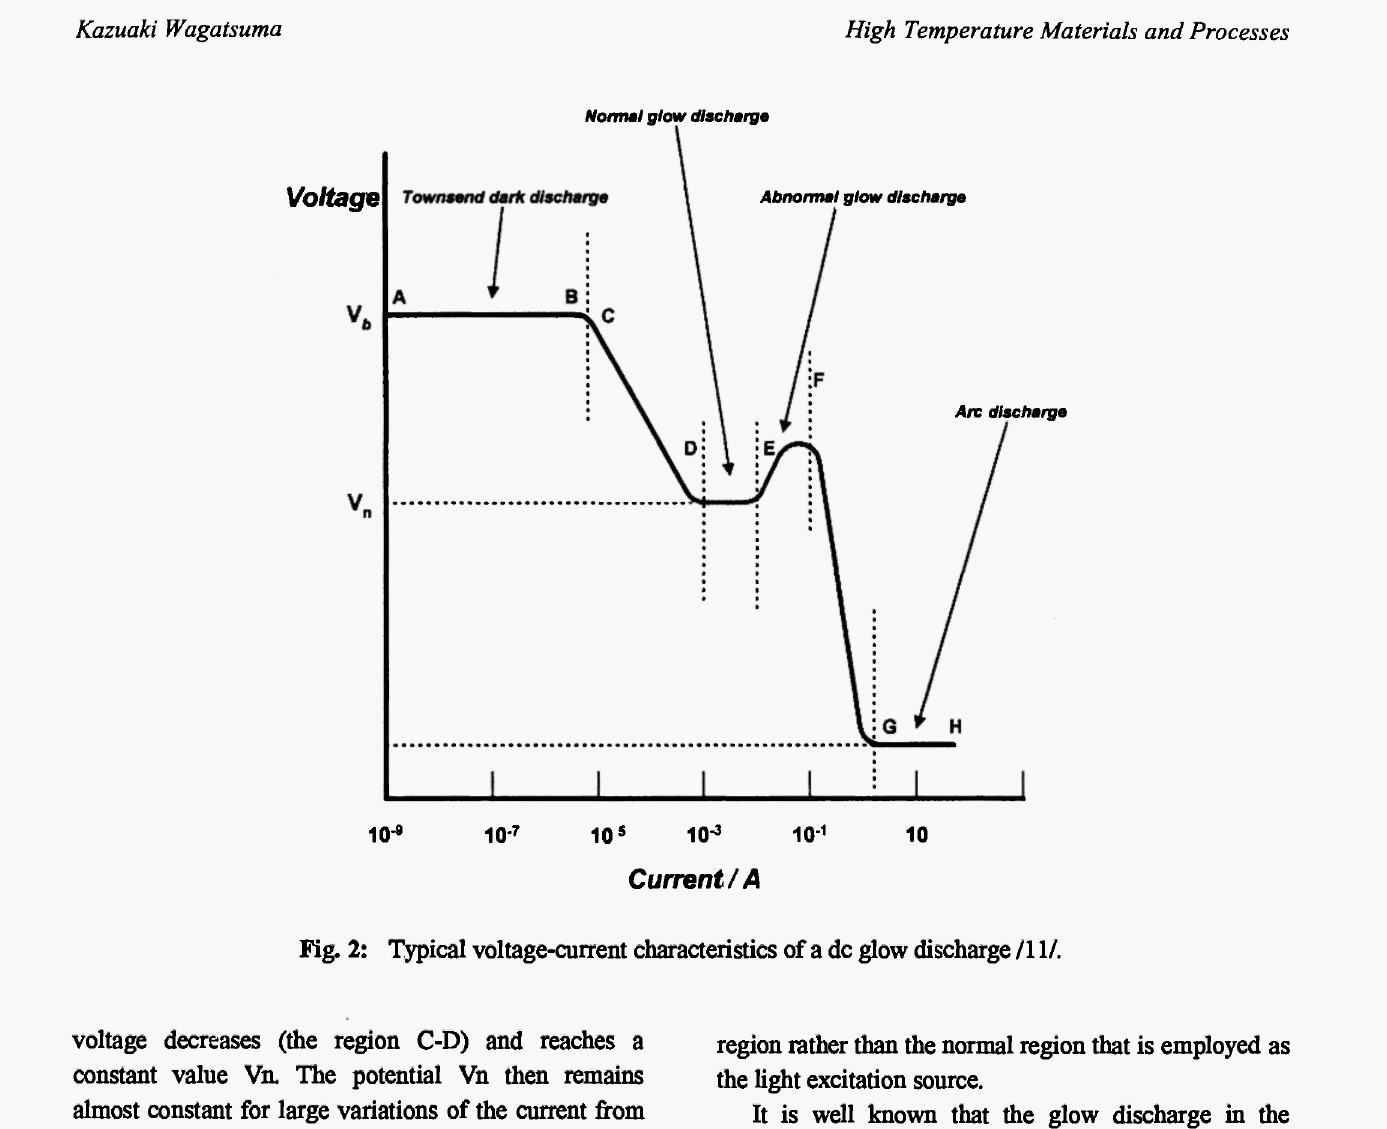
Fig. 2: Typical voltage-current characteristics of a dc glow discharge